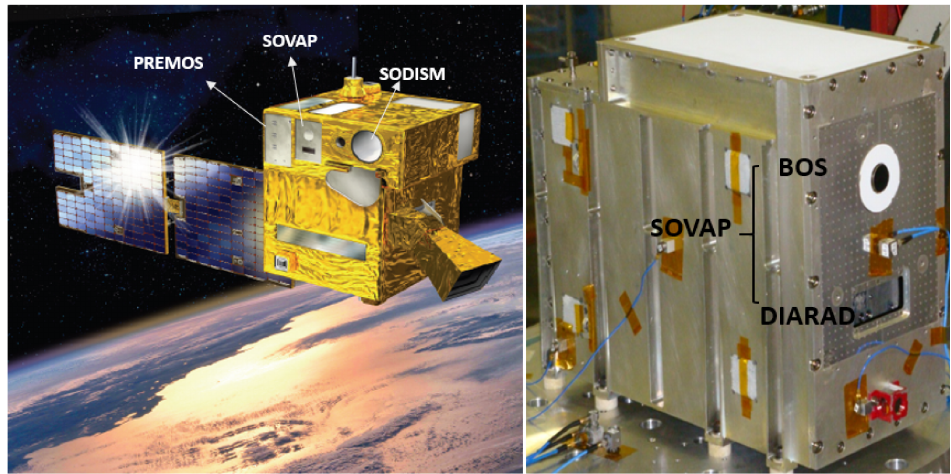
Figure 1. The PICARD satellite and SOVAP experiment. The BOS is integrated into the same unit with DIARAD (photo credits: CNES).